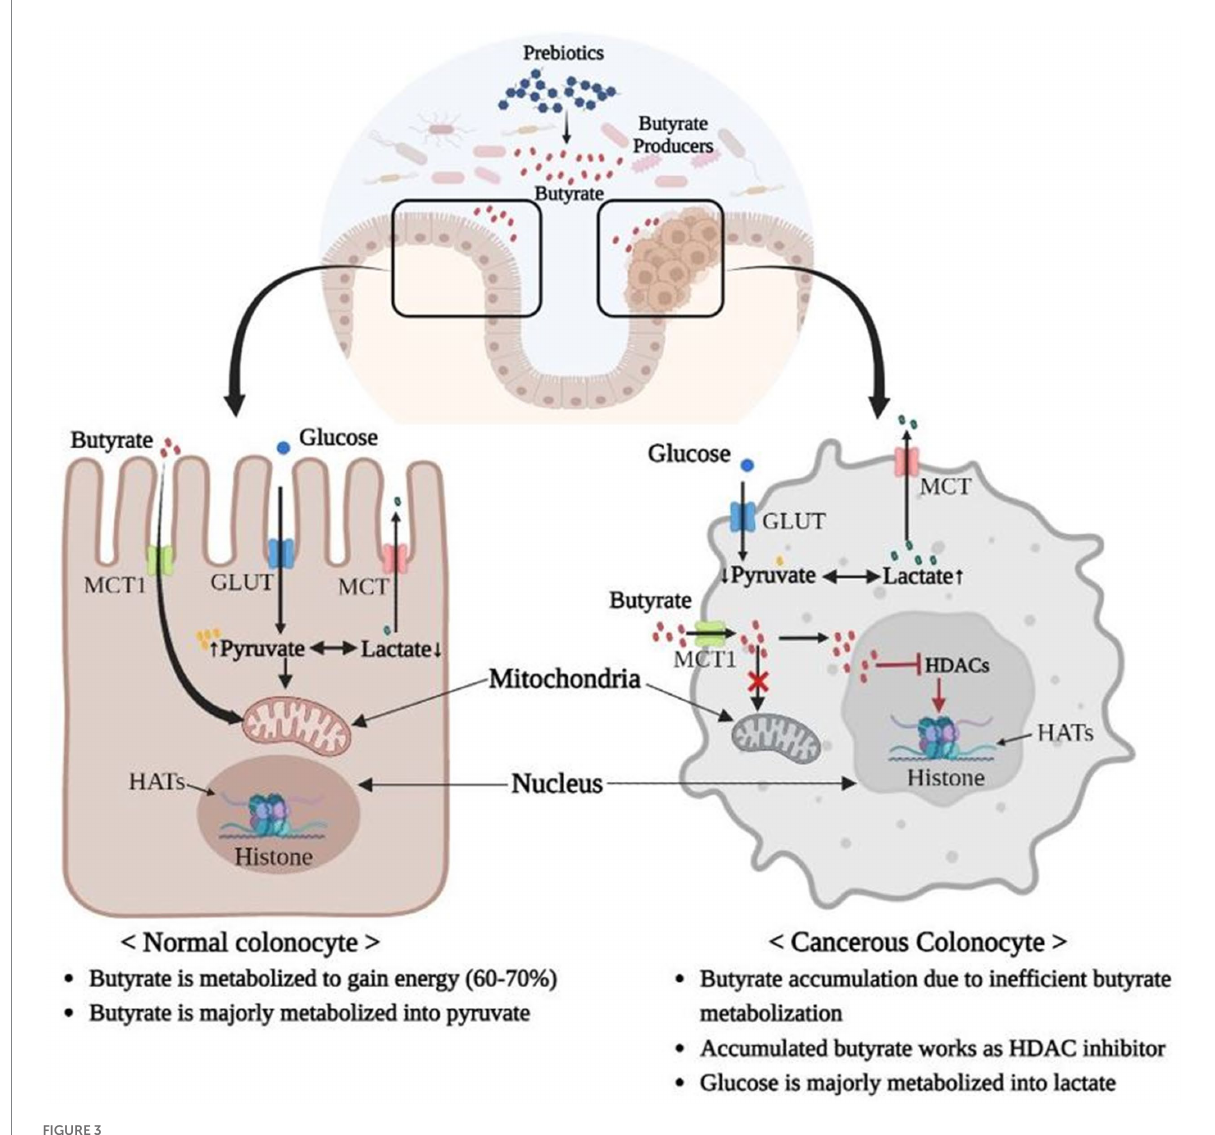
FIGURE 3 Warburg Effect: Inefficient butyrate metabolization by mitochondria of cancerous colonocytes leads to accumulation of butyrate, which in turn acts as an HDAC inhibitor and induces cancer. Additionally, majority of glucose is converted into lactate in cancerous colonocytes owing to their higher glycolysis rates, which is less energy efficient compared to phosphorylation of pyruvate in mitochondria via the TCA cycle. Therefore, cancerous colonocytes need higher glucose inflow and a higher rate of glycolysis to survive (MCT, Monocarboxylate Transporter; GLUT, Glucose Transporter; HDAC, Histone deacetylase, HAT; Histone